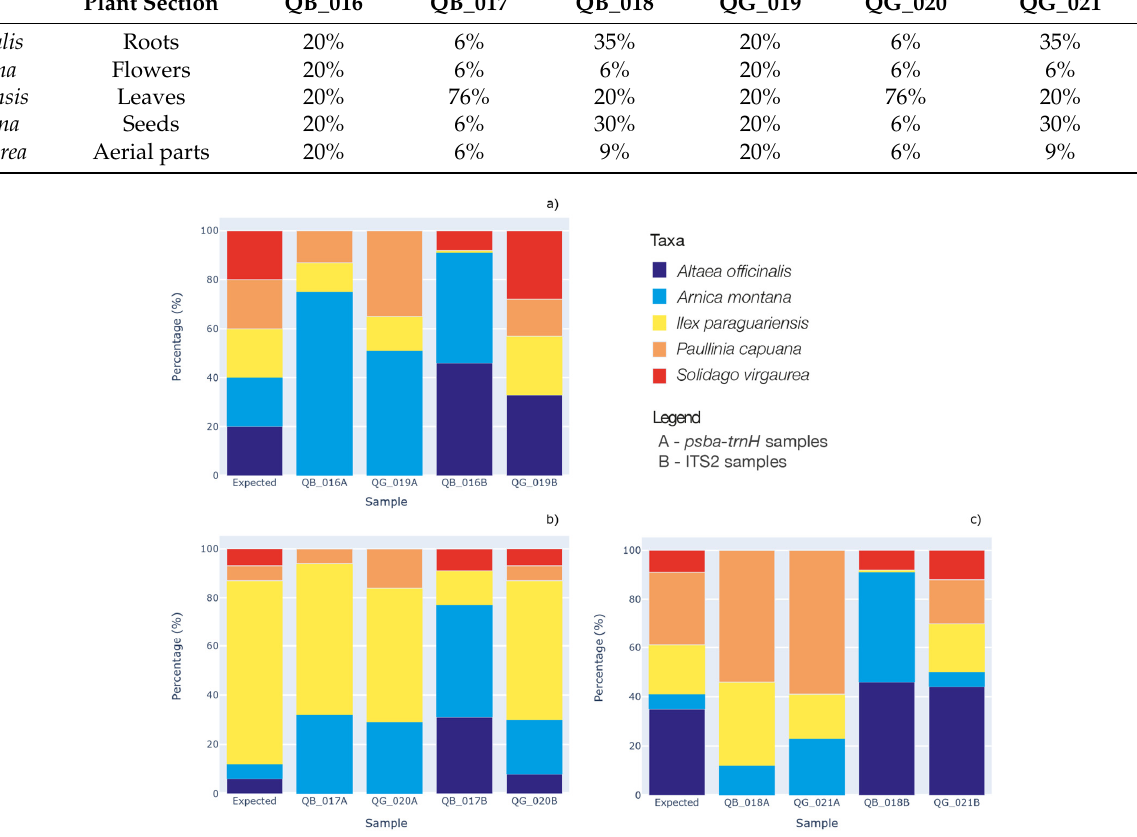
Figure 4. Graphs showing the expected percentages and the percentages obtained after